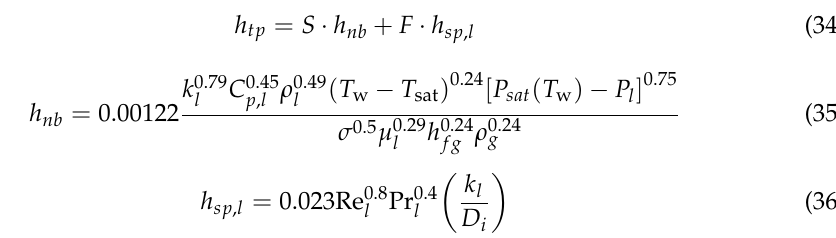
10 kW · m − 2 . The figure shows the calculation area with the pipe axis on the left and the